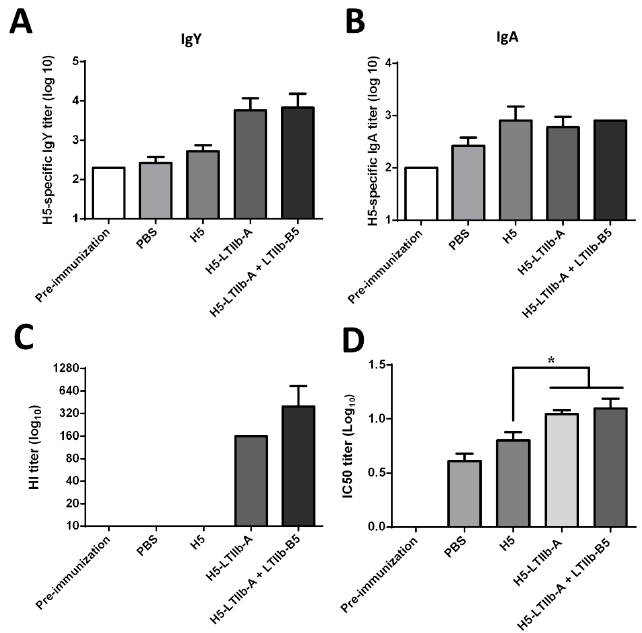
Figure 6. Intransal immunization with H5-LTIIb-A fusion protein in chickens. Chicks (three per group) were intranasally administered with three doses of H5-LTIIb-A fusion protein (10 µ g), H5 protein (10 µ g), the H5-LTIIb-A fusion protein (10 µ g) in combination with the LTIIb-B5 protein (5 µ g), or PBS (as sham control). ( A ) H5-specific IgY titer, ( B ) H5-specific IgA titer, ( C ) viral hemagglutinin inhibition (HAI) titer, and ( D ) neutralizing antibody titer of antisera from the immunized chickens. Kaplan–Meier analysis was adopted for survival analysis, with the statistical significance * p <